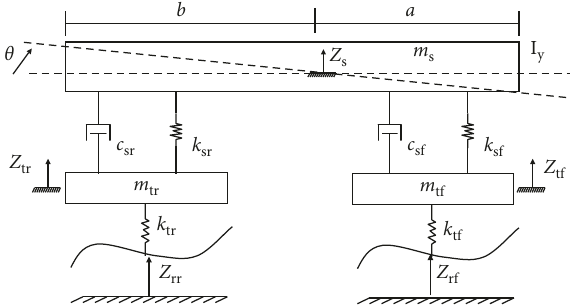
Figure 1: 4-DOF vehicle suspension system (bicycle